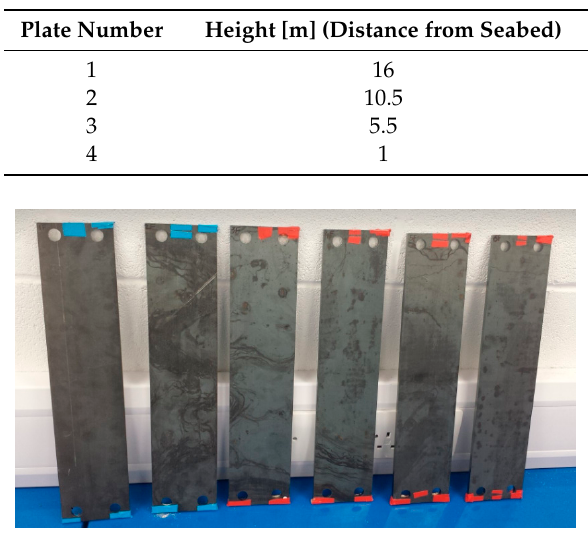
Figure 3. Colour coding and numbering of plates.